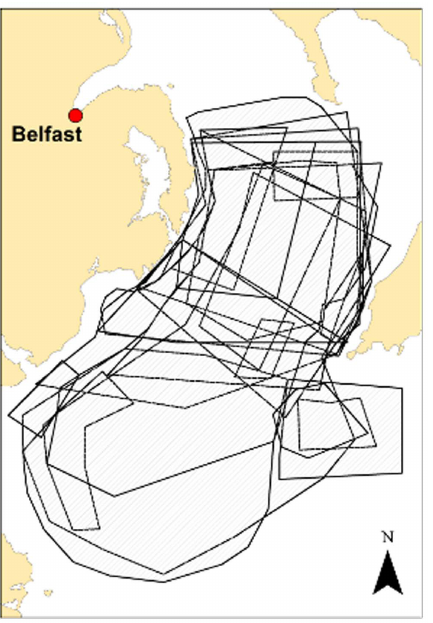
Figure 10. Spatial overlap of fishers’ access priority areas within a given gear-length-port combination. Map of the access priority areas chosen by nine Nephrops fishers, from Northern Ireland. The nine fishers’ vessels were within a given port-length combination and the map shows the spatial overlap in their responses.